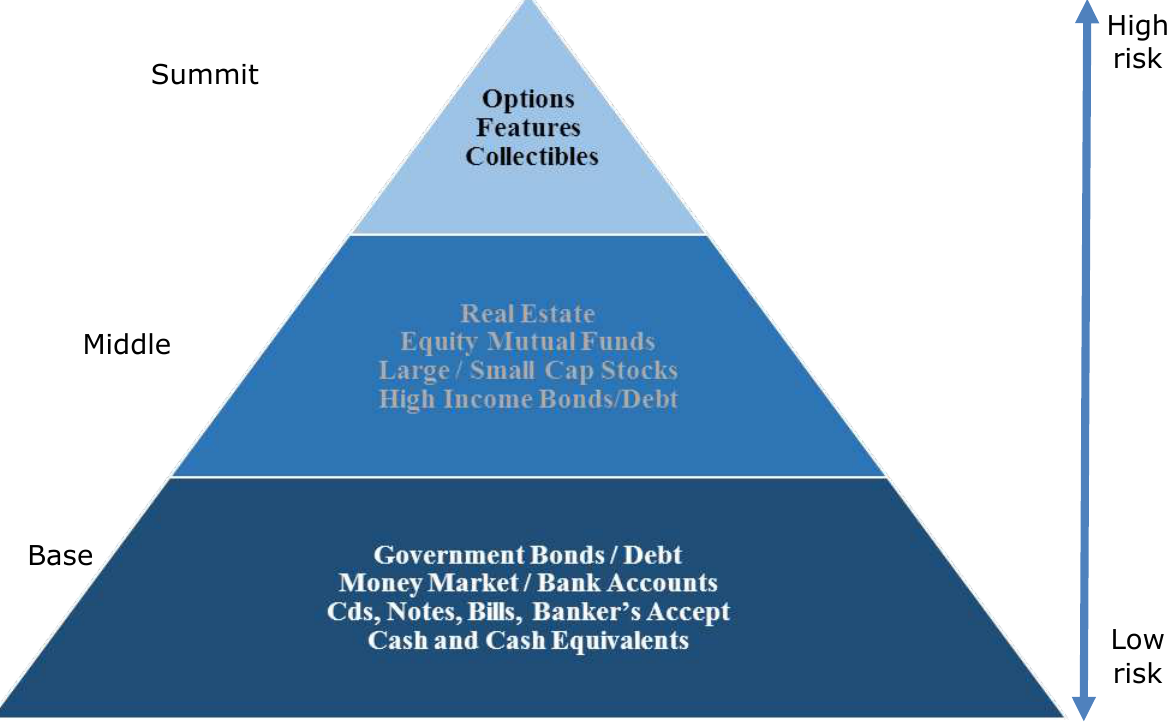
Figure 1. Behavioral portfolio